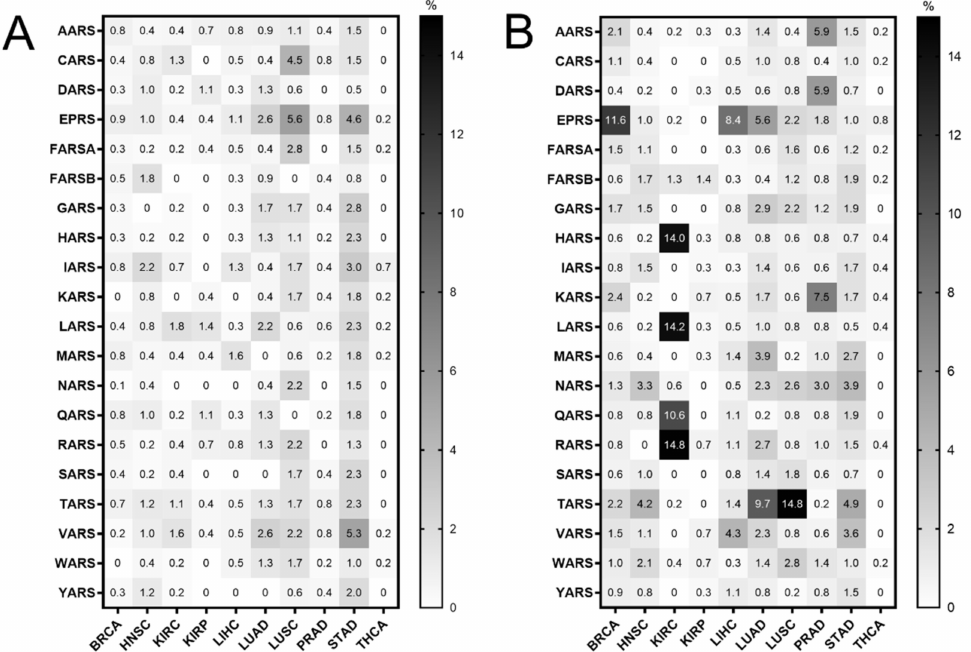
Figure 1. ARS mutational alteration frequencies (%) in TCGA cancers. ( A ) Point mutation alteration frequencies. These include non-silent mutations, such a as nonsense, missense or splice-site introduc- ing mutations. ( B ) Copy number alteration (CNA) frequencies. These include gains/amplifications and